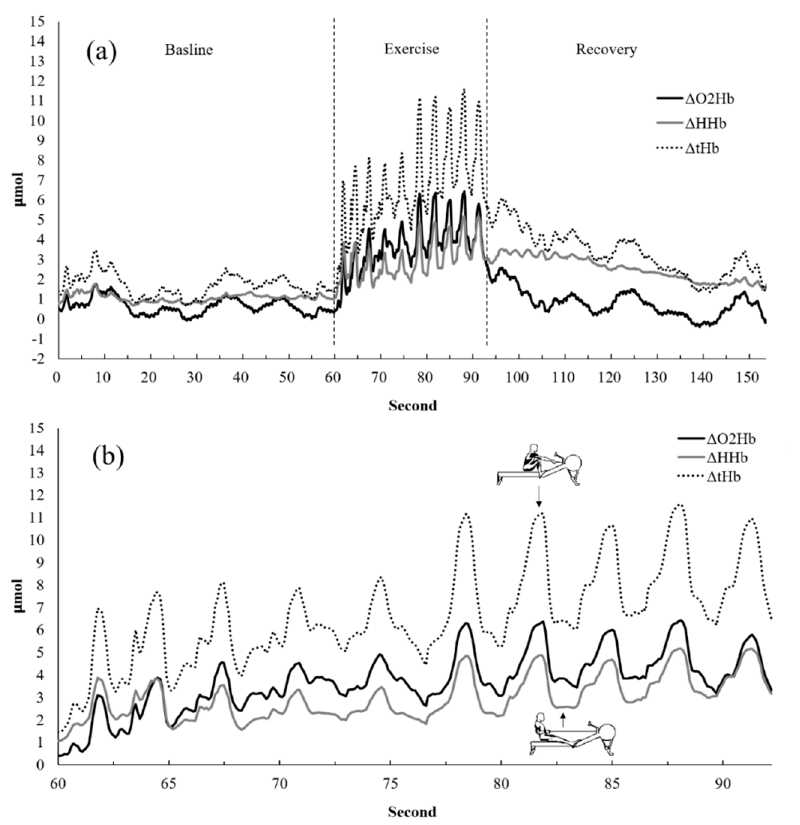
Figure 2. Representative participant’s erector spinae muscle oxygenation response ( a ) during the rowing exercise test and ( b ) during the drive and recovery phase in the rowing exercise test. ∆ O2Hb: oxyhemoglobin change. ∆ HHb: deoxyhemoglobin change. ∆ tHb: total hemoglobin change.